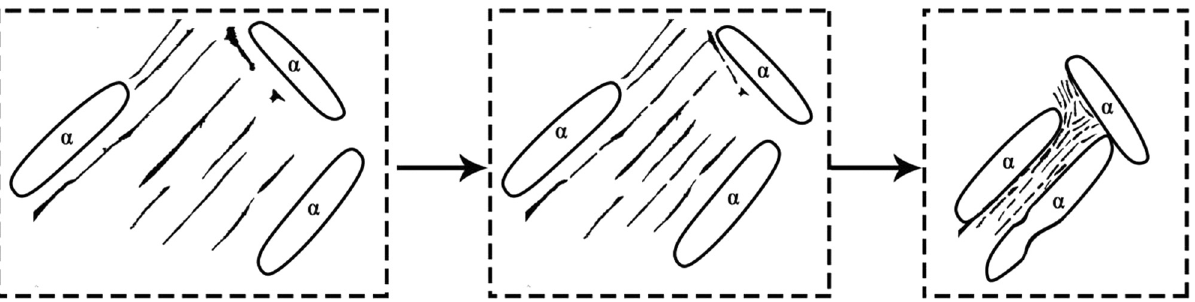
Figure 13: The evolution process of the α phase and β - transformed